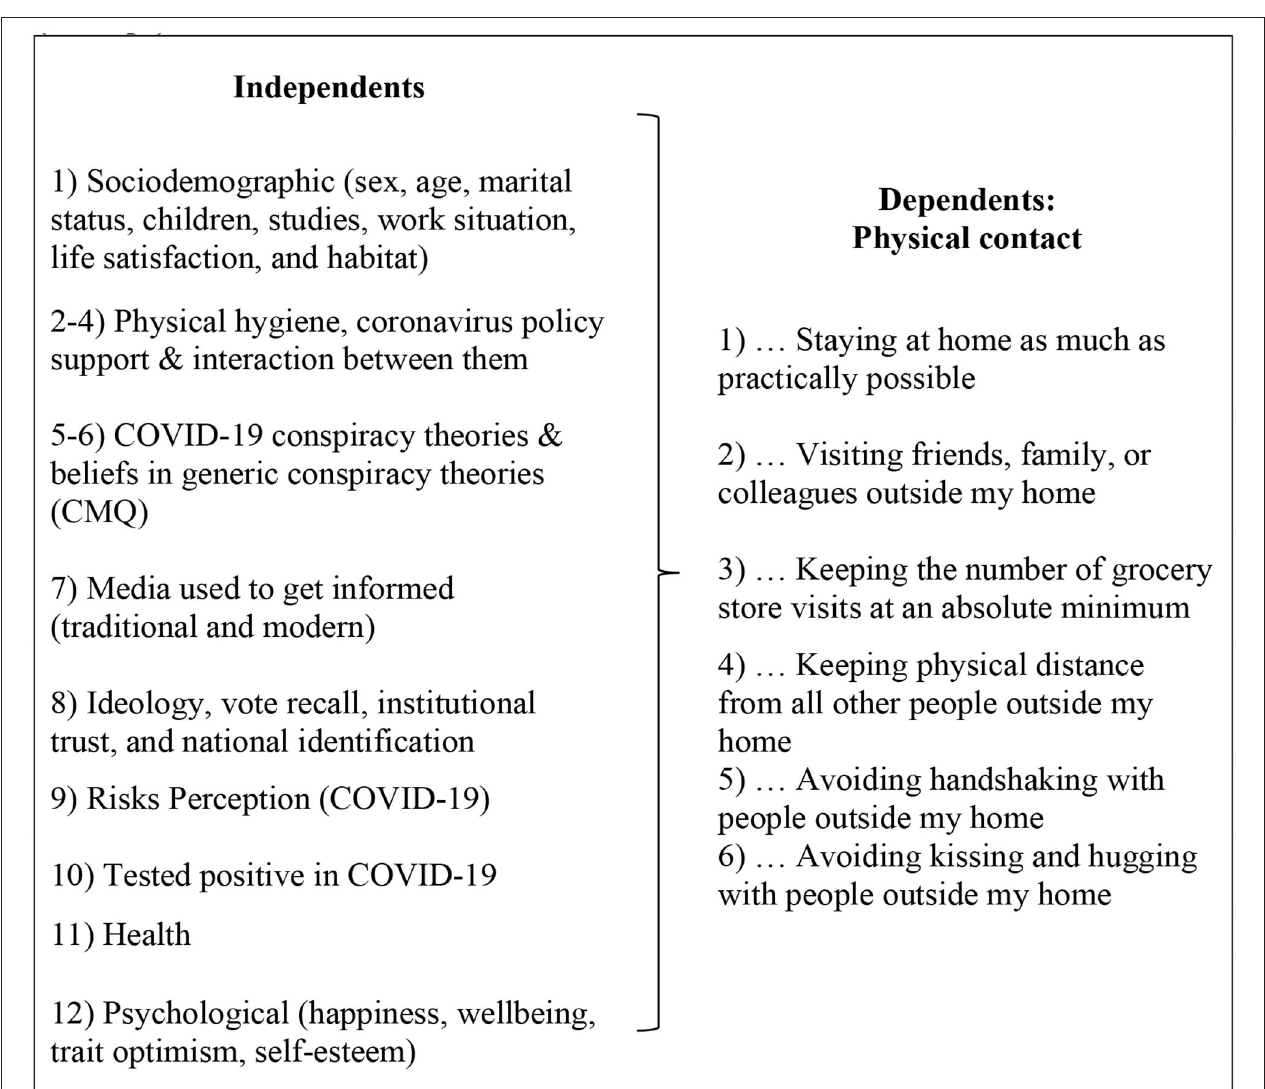
FIGURE 2 | Dimensions and variables included in the six hierarchical multiple regression models (12 steps). Source: